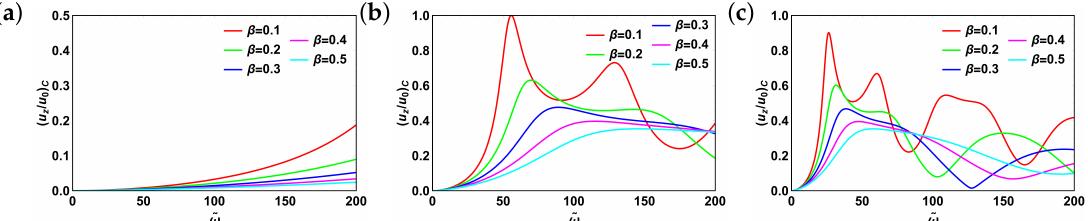
Figure 3. Centerline velocity profile for fractional Maxwell model: ( a ) ˜ a = 0.01; ( b ) ˜ a = 0.05; ( c ) ˜ a = 0.1. For all plots α = 0.5. Subscript “c” stands for